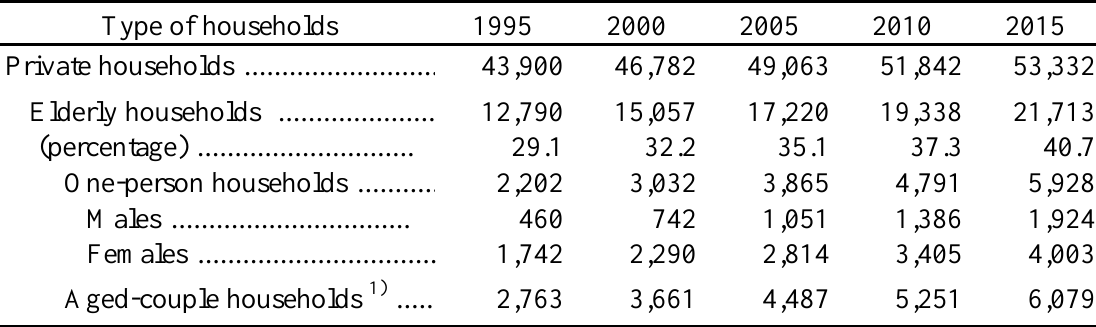
Trends in Elderly